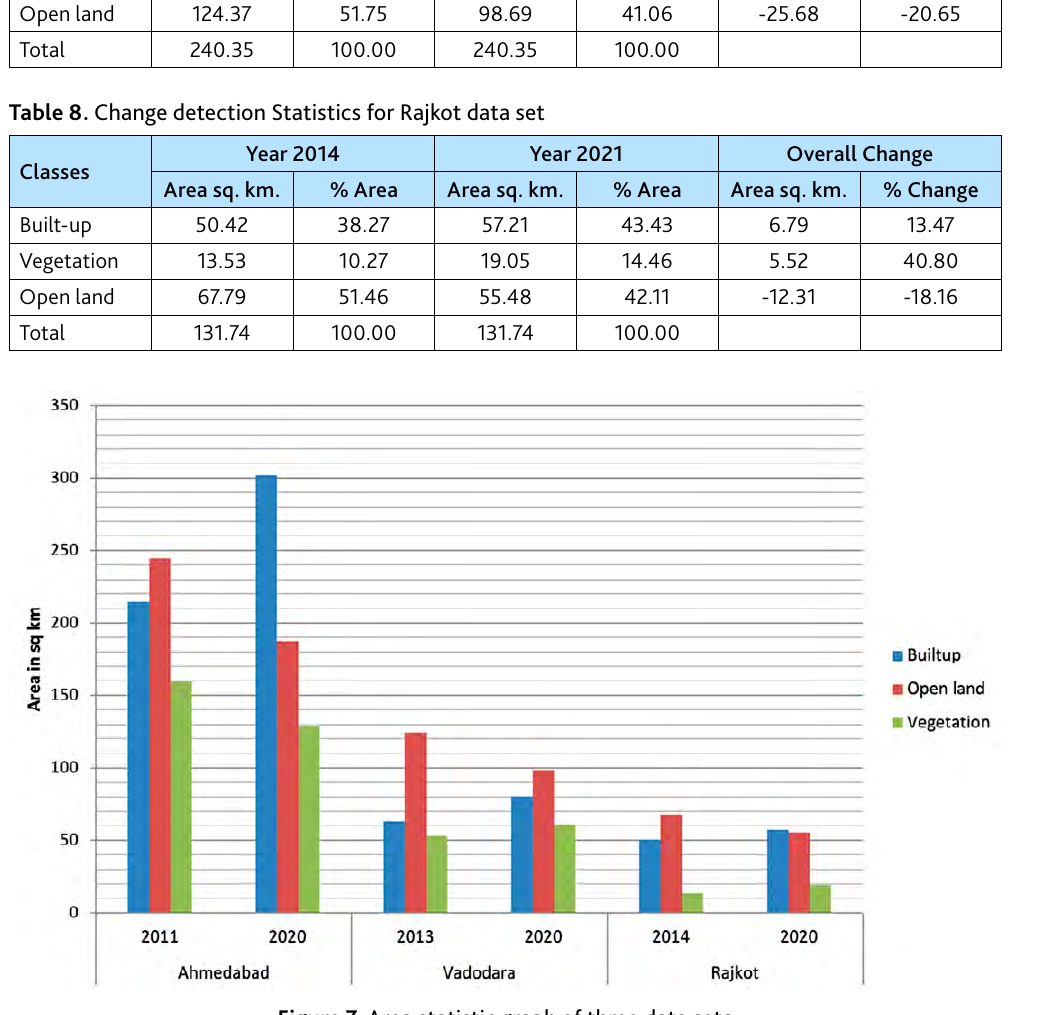
Figure 7. Area statistic graph of three data